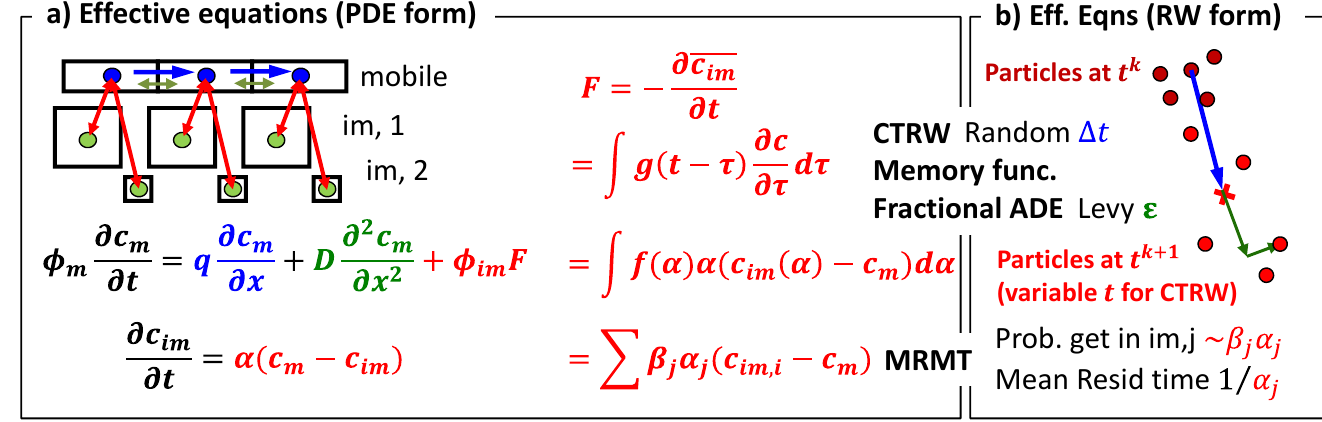
Figure 11. Effective transport equations can be written in ( a ) PDE form (multicontinuum with an exchange term, often implicit, expressed in terms of a memory function 𝐠 , or a distribution of immobile regions with residence time 1 α⁄ ) or ( b ) RW form (with “anomalous” noise).